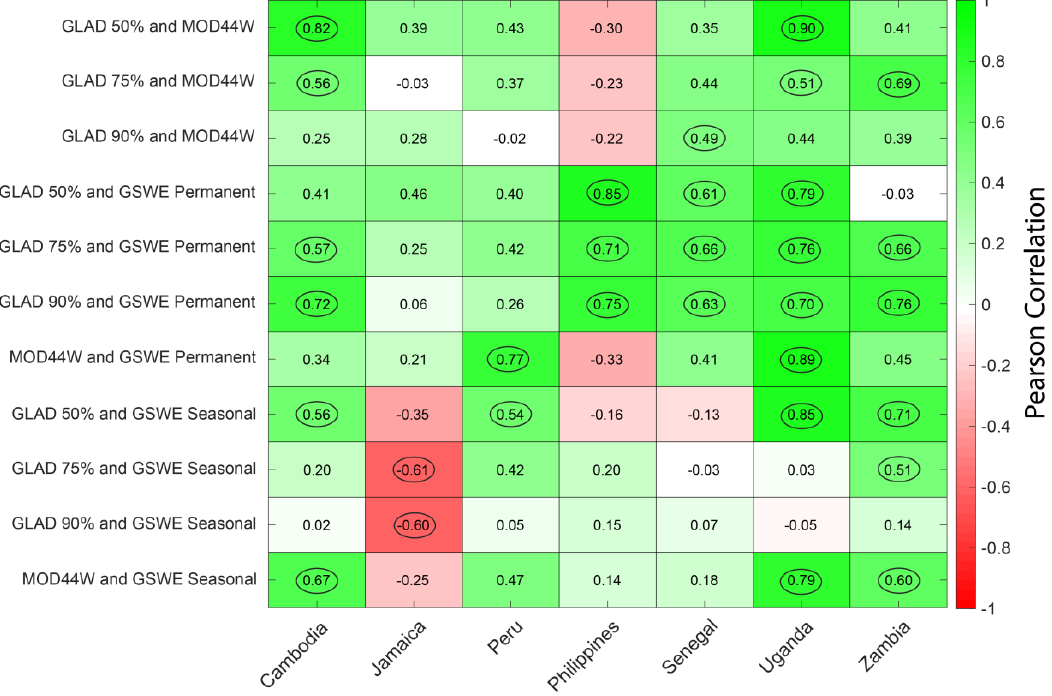
Figure 6. Correlations of yearly surface water extent in the seven countries calculated between MOD44W C6.0, GSWE permanent water and seasonal water, and GLAD surface water using three different persistent water thresholds (50%, 75%, and 90%). Correlation values between datasets are displayed in each box and statistically significant correlations are circled. Statistical significance was determined at a p -value ≤ 0.05 using the t-test.